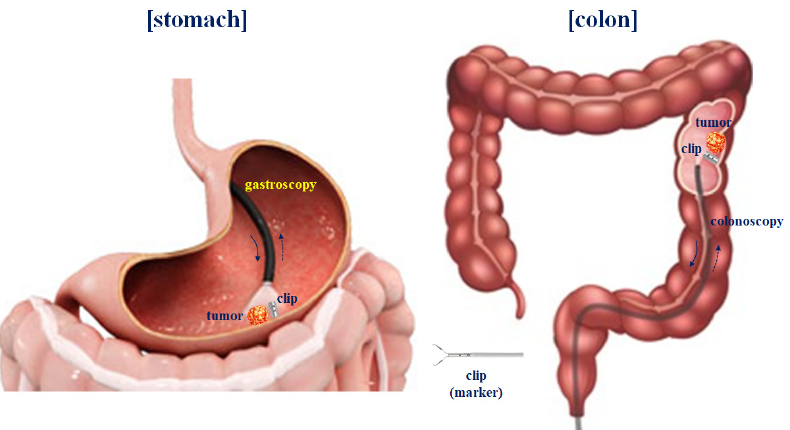
Figure 11. Process of installing clips in the mucosa of the stomach and colon using an endoscope.